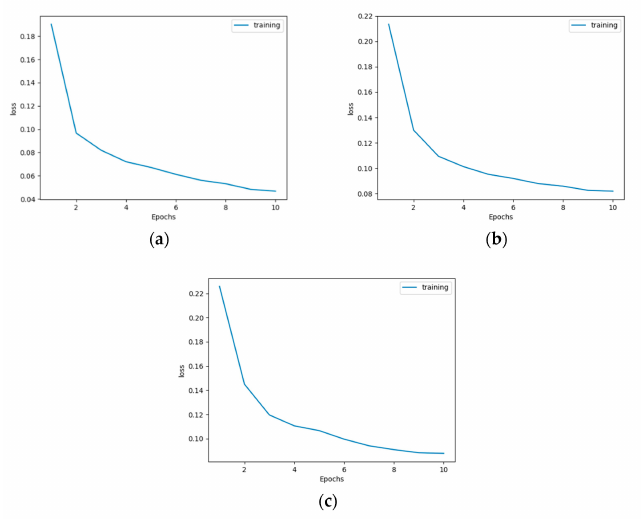
Figure 10. Training curve of ( a ) conventional U-Net, ( b ) improved U-Net #1, and ( c ) improved U-Net